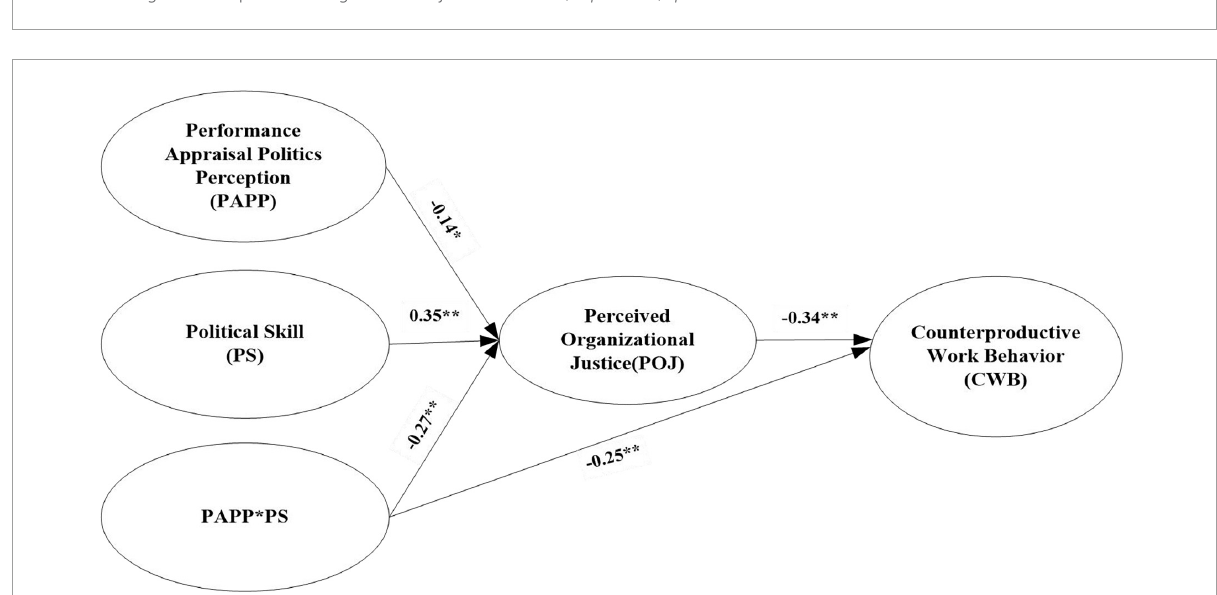
FIGURE4 The Moderating model of political skill. N = 460, ** p < 0.01, * p <